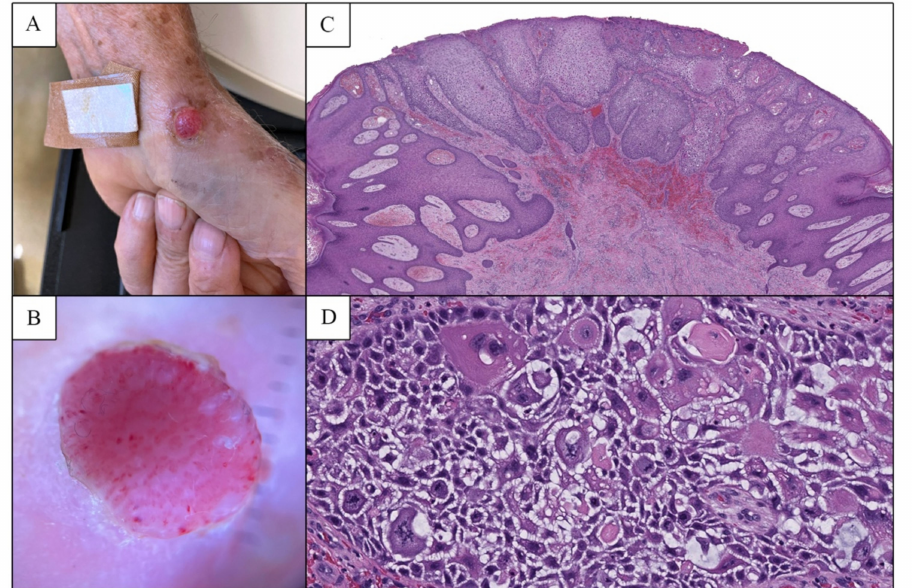
Figure 2. ( A ) Clinical image of the regrown lesion on the left thenar eminence after initial biopsy, appearing similar to the original lesion in Figure 1A. ( B ) Dermoscopic examination of this lesion showed glomerular vessels in a reticular pattern. ( C ) Low power examination of the subsequent excision specimen revealed an epidermal tumor composed of pale-staining cells with sharp lateral de- marcation from the surrounding skin (H&E, 20 × ). ( D ) Pleomorphism with mono-and multinucleated keratinocytes and numerous mitotic figures, including atypical forms, were identified (H&E, 200 ×